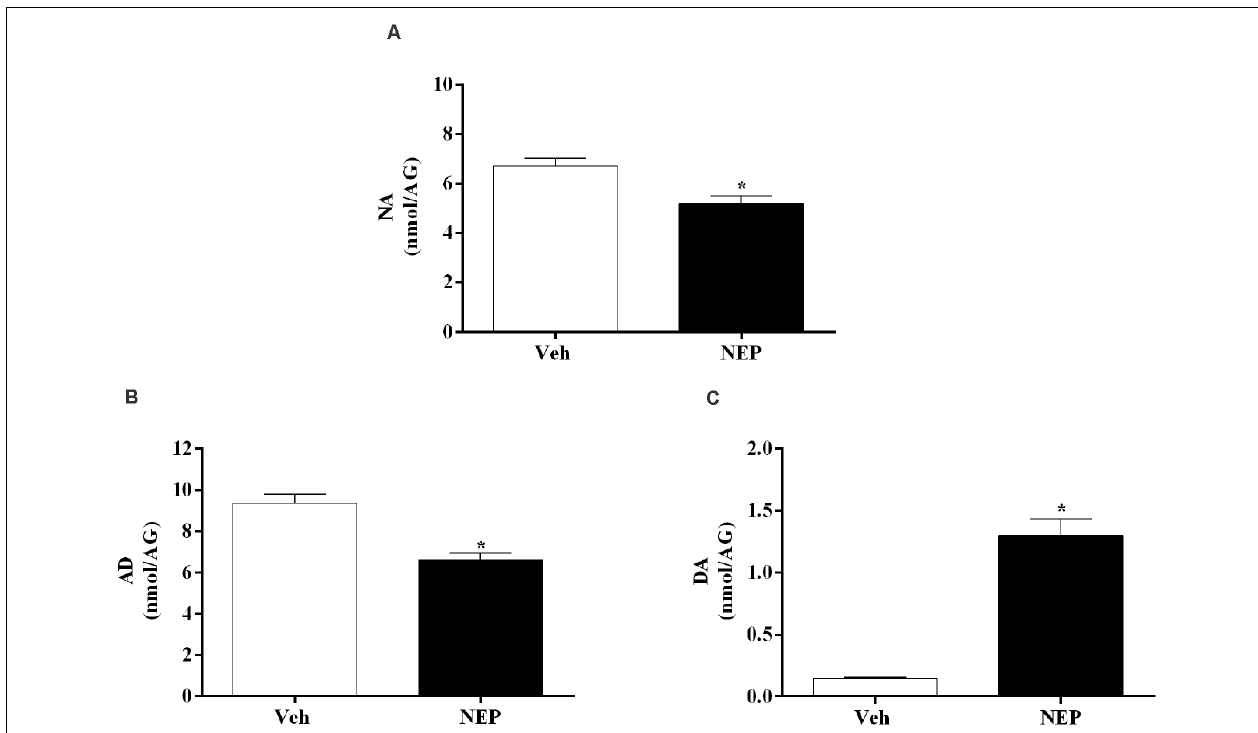
FIGURE 6 | Concentration of (A) noradrenaline (NA), (B) adrenaline (AD), and (C) dopamine (DA) in the adrenal gland (AG) expressed as nmol/AG on day 7 after post-traumatic stress disorder (PTSD) induction. Values are means ± SEM of 5–7 mice per group. Veh, mice in the PTSD-group and treated with vehicle; NEP, mice in the PTSD-group and treated with nepicastat; *, significantly different from correspondent values in mice in the PTSD-group and treated with vehicle ( p < 0.05).